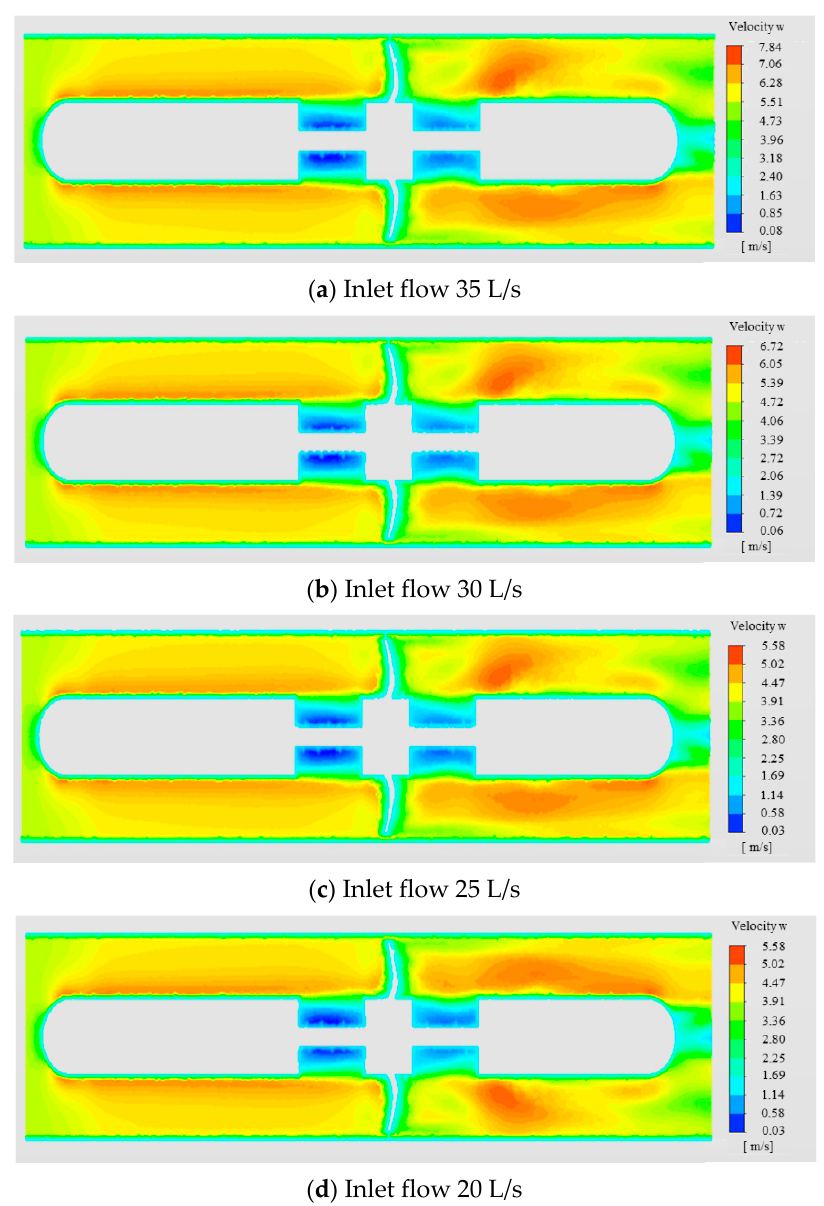
Figure 9. Cloud map of instantaneous dynamic axial velocity distribution under four flow rates.